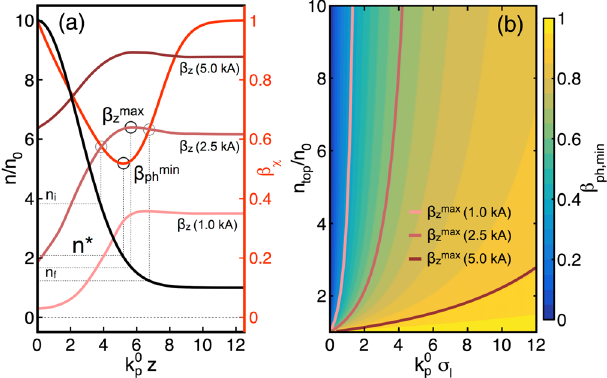
¼ top and k 0 p σ l top